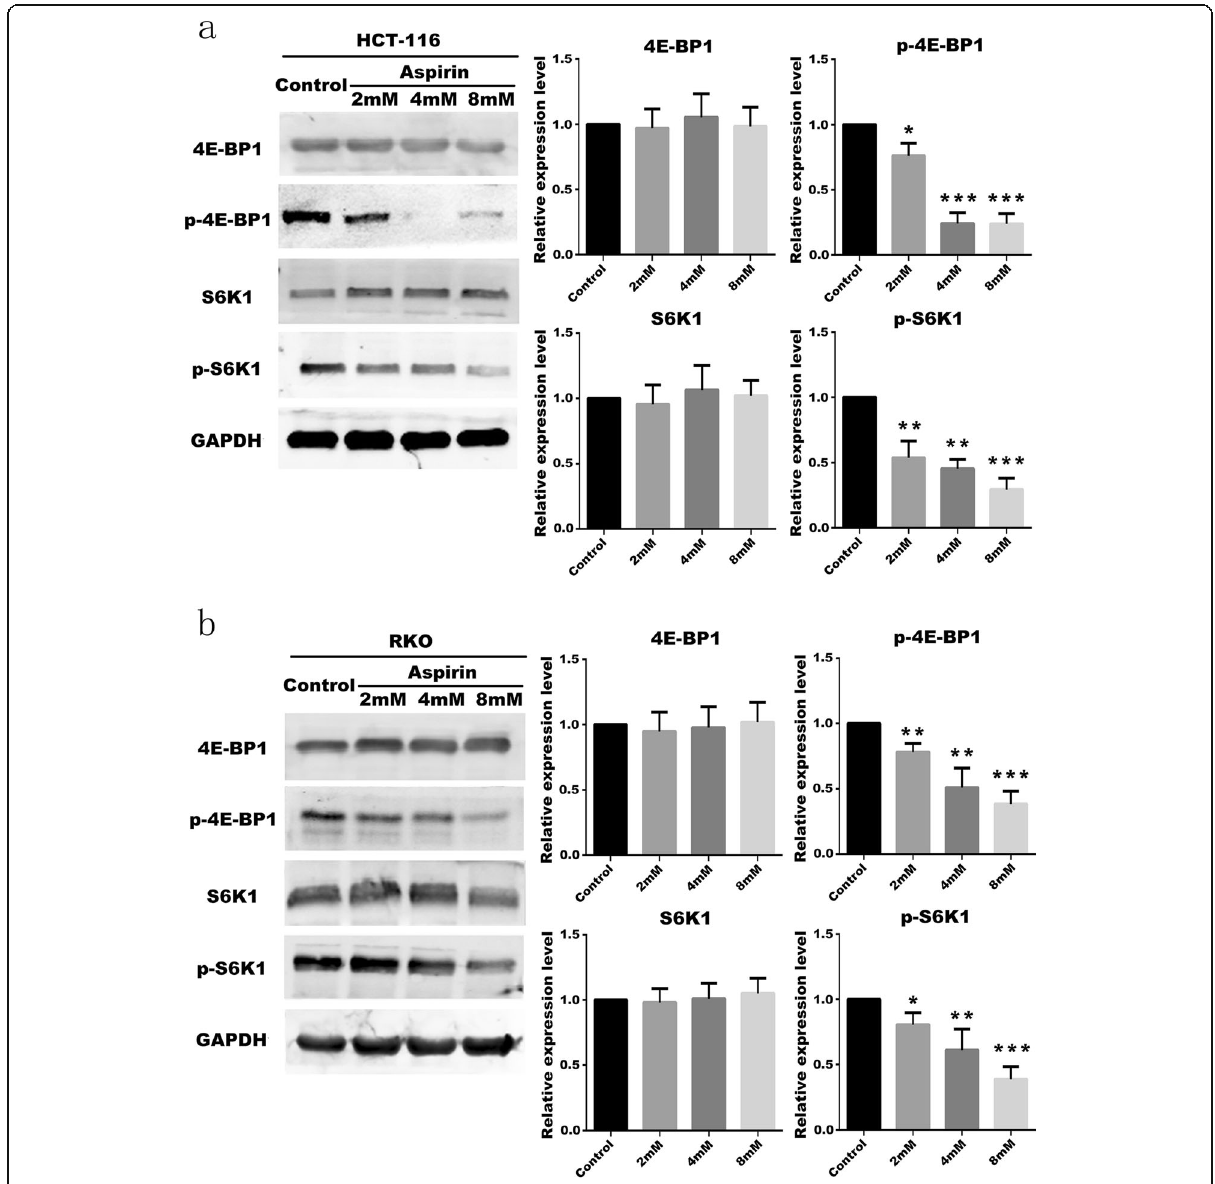
Fig. 5 Aspirin inhibits CRC cell proliferation a Expression of S6K1, 4E-BP1 protein and protein phosphorylation in HCT-116 cells treated with different concentrations of aspirin. b Expression of S6K1, 4E-BP1 protein and protein phosphorylation in RKO cells treated with different concentrations of aspirin. All experiments were repeated 3 times, ( n = 3) Mean ± SD. * P < 0.05, ** P < 0.01 and *** P < 0.001 (vs. normal